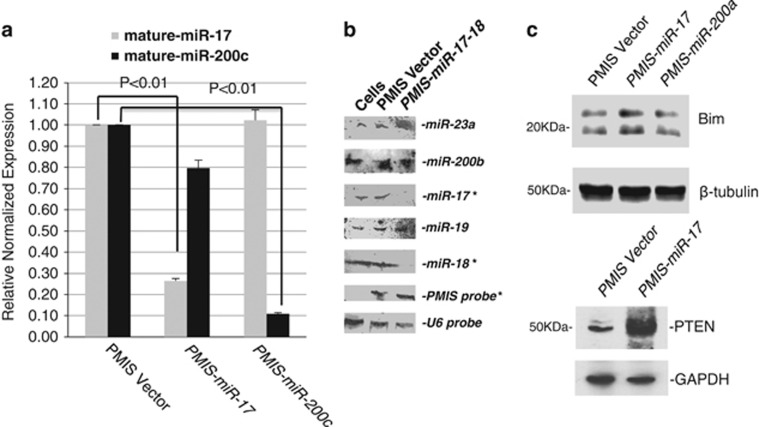
Efficiency of the PMIS. (a) PMIS-miR inhibitors reduce specific miR expression. RT-PCR of mature endogenous miR-17 and miR-200c from 293 cells transfected with the indicated PMIS inhibitor. (b) Northern blot of mature endogenous miRs and the PMIS construct from 293 cells transfected with PMIS vector or PMIS-miR-17-18. U6 RNA is shown as a loading control. (c) Western blot of Bim, a known target of miR-17 from cells transfected with the PMIS vector, PMIS-miR-17 or PMIS-miR-200a. In addition, a western blot of PTEN, identified as a target of miR-17. β-Tubulin and GAPDH (glyceraldehyde 3-phosphate dehydrogenase) are shown as loading controls.